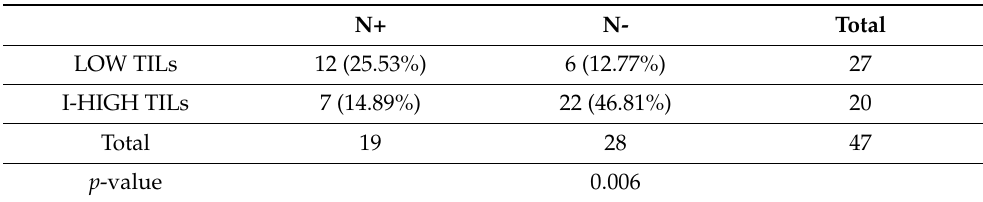
Table 3. Relation between TILs and nodal